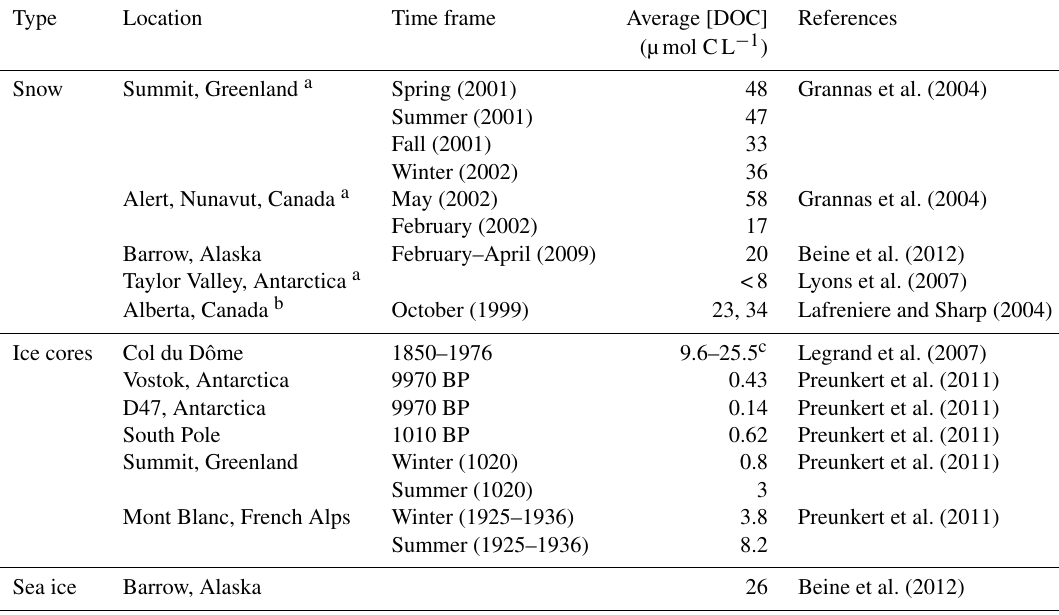
Table 2. Average dissolved organic carbon concentrations in snow and ice from past